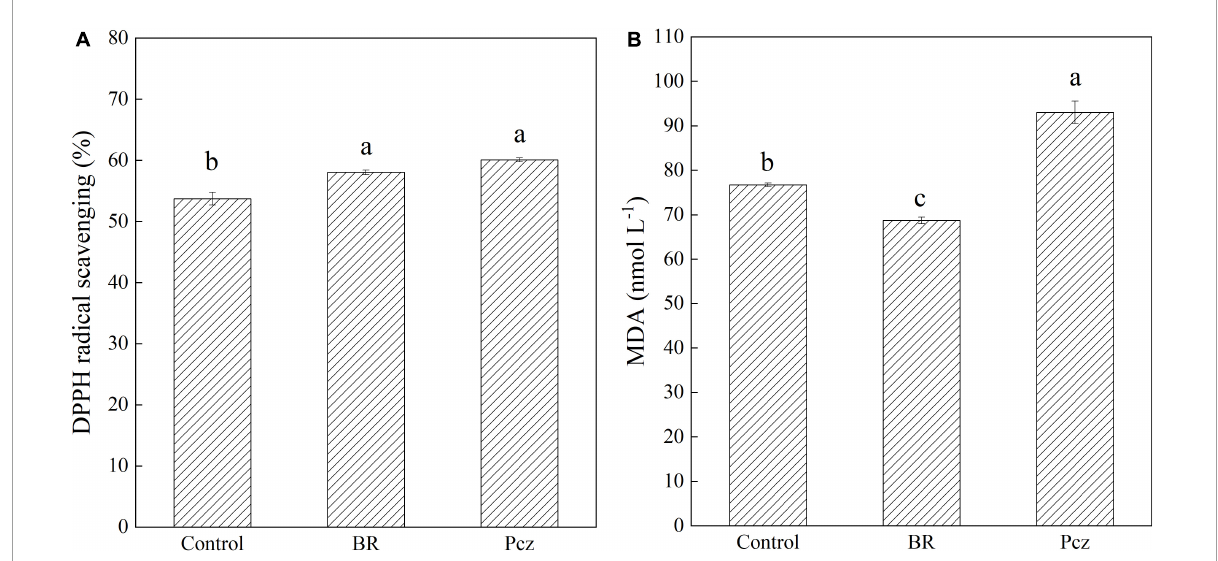
FIGURE3 DPPH radical scavenging activity (A) , and malondialdehyde content [MDA (B) ] in bulbil of P. ternata under BR and Pcz treatments. The bars with different letters are significantly different from each treatment ( p < 0.05). Values are means of four replicates ± SE.